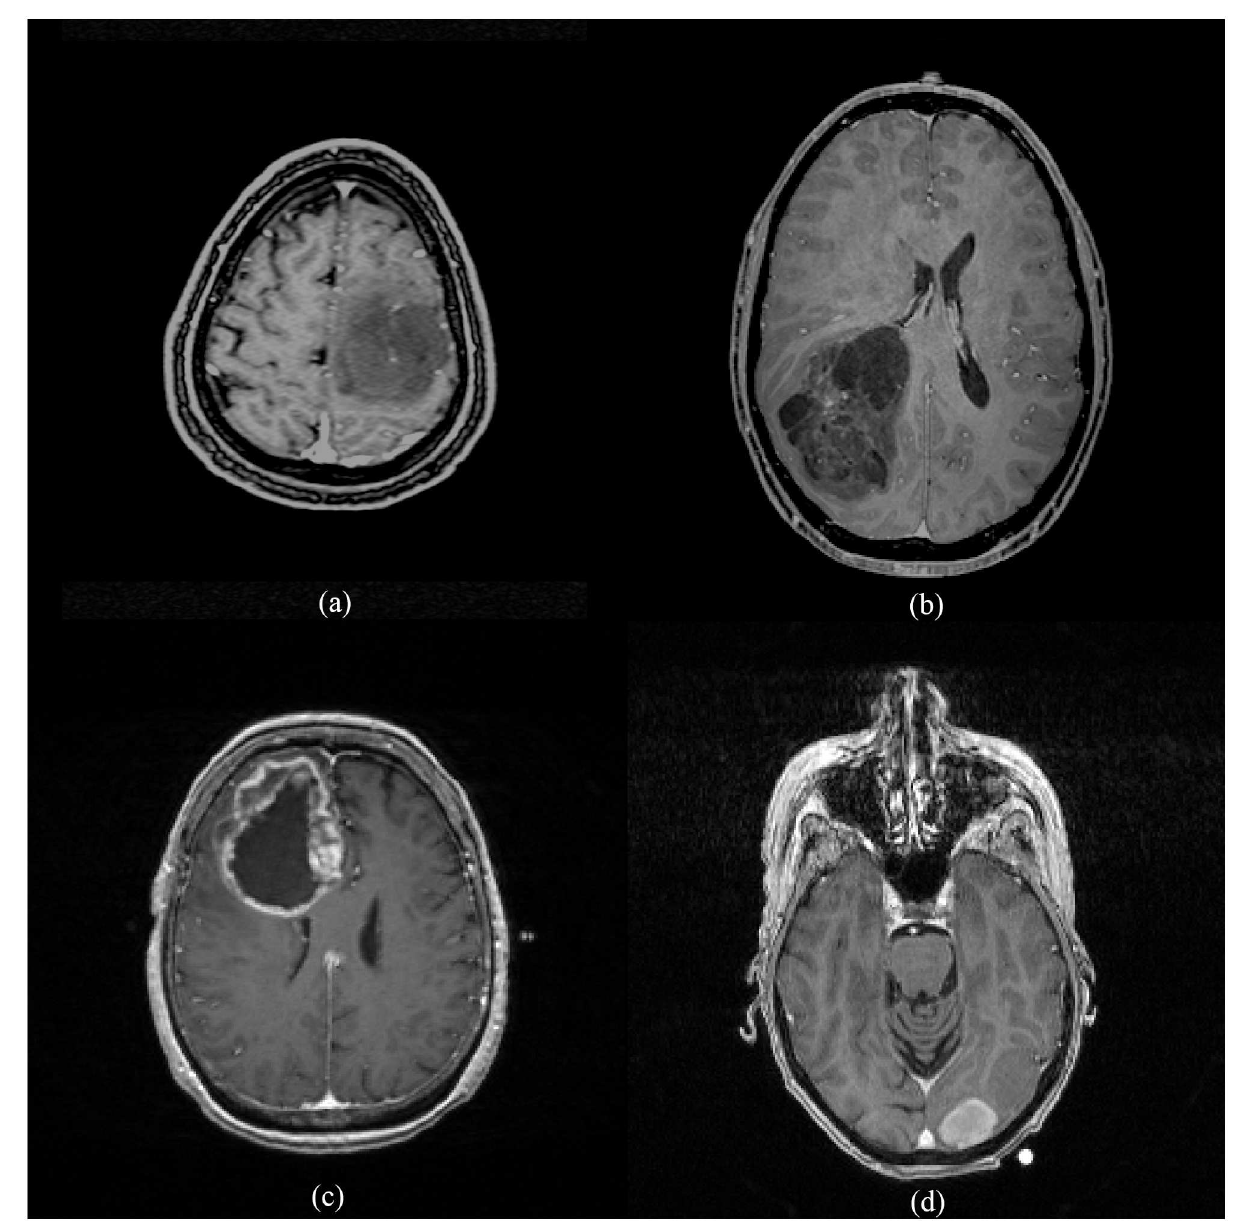
Fig 1. Two cases of low-grade gliomas (a, b) and two cases of glioblastomas (c, d) used in the experiment showing the heterogeneity among these brain tumors. (http://cancerimagingarchive.net/ - "License", the CC BY license (https://creativecommons.org/